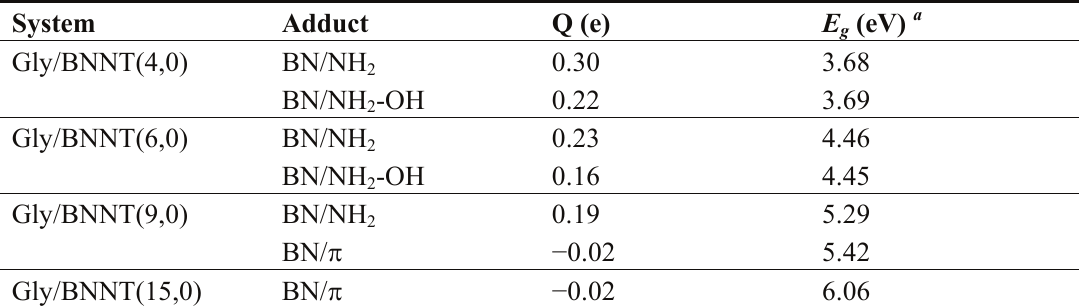
Table 2. Muliken charge (Q) of Gly adsorbed on the BNNTs in the most stable adducts and respective calculated direct band gaps ( E g